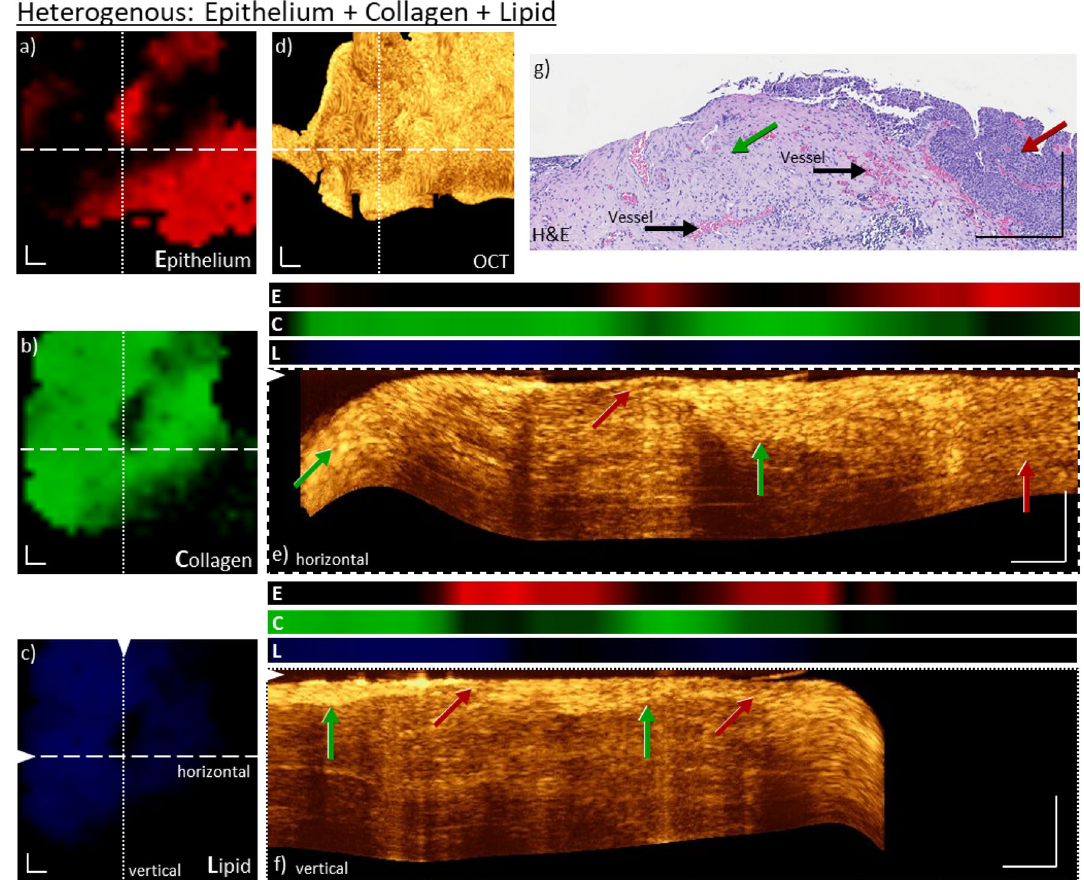
Figure 4. Co-registered, morpho-molecular information of OCT and Raman images on a bladder biopsy with strong epithelium and collagen signals. Enface Raman map for epithelium ( a ) and collagen ( b ) display primarily strong and heterogenous signals. Minor lipid signal is also present in the image ( c ). The corresponding enface OCT maximum intensity projection of ten slices from a depth of 120–150 µm is shown in ( d ). Maximum intensity projections of ten cross-sectional OCT B-scans, positions indicated by dashed and dotted lines in the enface image ( e , f ) with co-registered molecular Raman information (E: Epithelium, C: Collagen, L: Lipid). Both B-scans exhibit transition zones of bright and dark layers, which correlate to the Raman signals of collagen and epithelium (red and green arrows). Especially on the right-hand side of ( e ), the signal of the whole cross-section appears dark in comparison to the collagen signal next to it on the left. The same transition of epithelium and collagen is also visible in the Raman signals. For comparison H&E image of the respective biopsy ( g ) shows thickened epithelium (red arrow) and collagen rich lamina propria (green arrow). Vessels are located in the upper lamina propria layer of the bladder wall and indicated in ( g ). Scale bars: 250